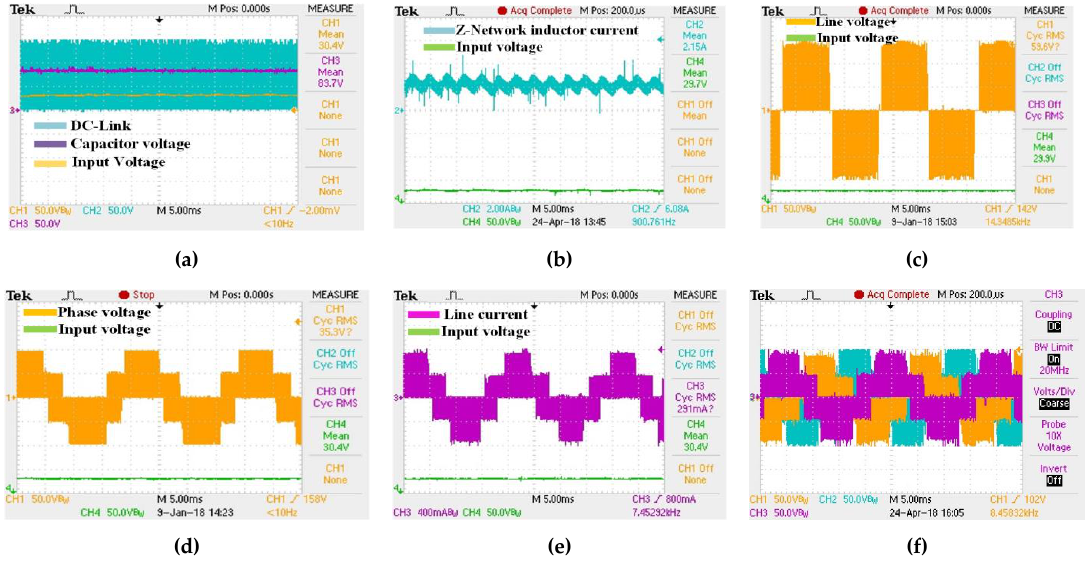
Figure 11. Experimental results outpt waveforms for the proposed modified ZSI-DCPWM with